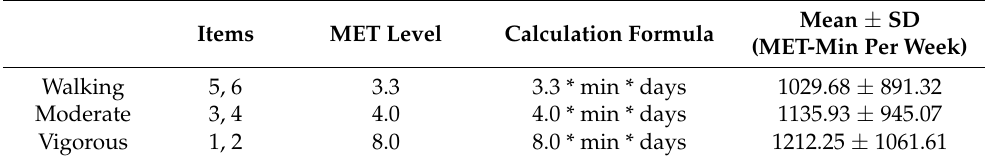
Table 1. Physical activity statistical methods and